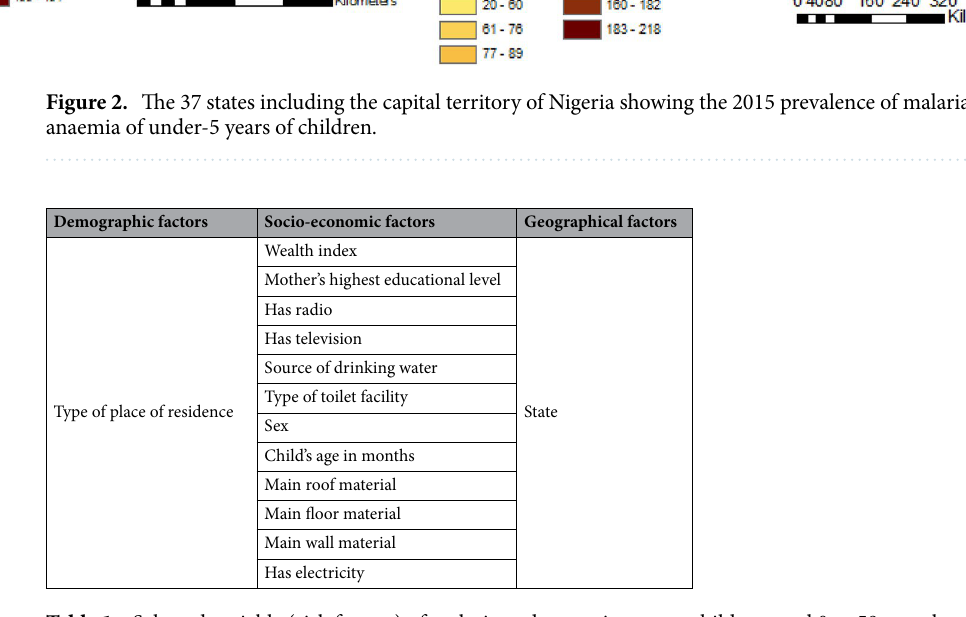
Table 1. Selected variable (risk factors) of malaria and anaemia among children aged 0 to 59